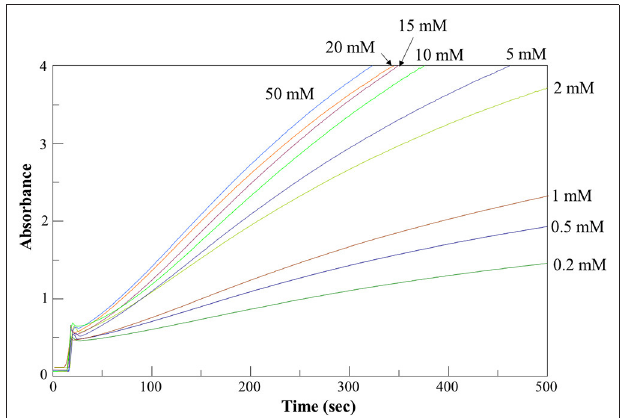
FIGURE 5 | AroH L-phenylalanine transaminase activity assay. Time-dependent changes of the absorbance at 365nm during the continuous assay of AroH (0.2 µ M) transaminase activity in the presence of L-phenylalanine at the indicated concentrations and 1mM α -ketoglutarate in 66mM KP, pH 7.4 at 25 ◦ C.